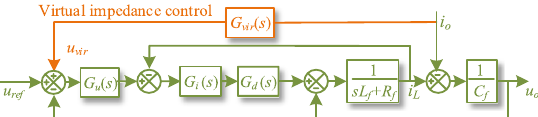
Fig. 3 Block diagram of the virtual impedance